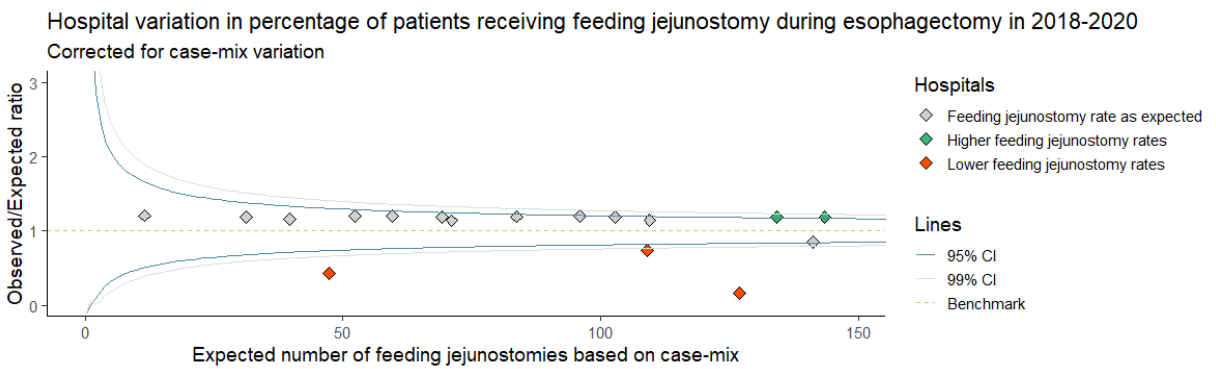
Figure 3. Case-mix corrected funnel plot showing hospital variation in the placement of feeding jejunostomies during minimally invasive esophagectomy in 2018–2020. CI = confidence interval.